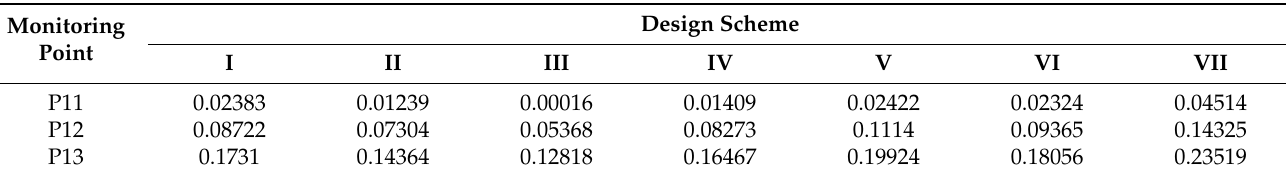
Table 2. Pulsation amplitudes at